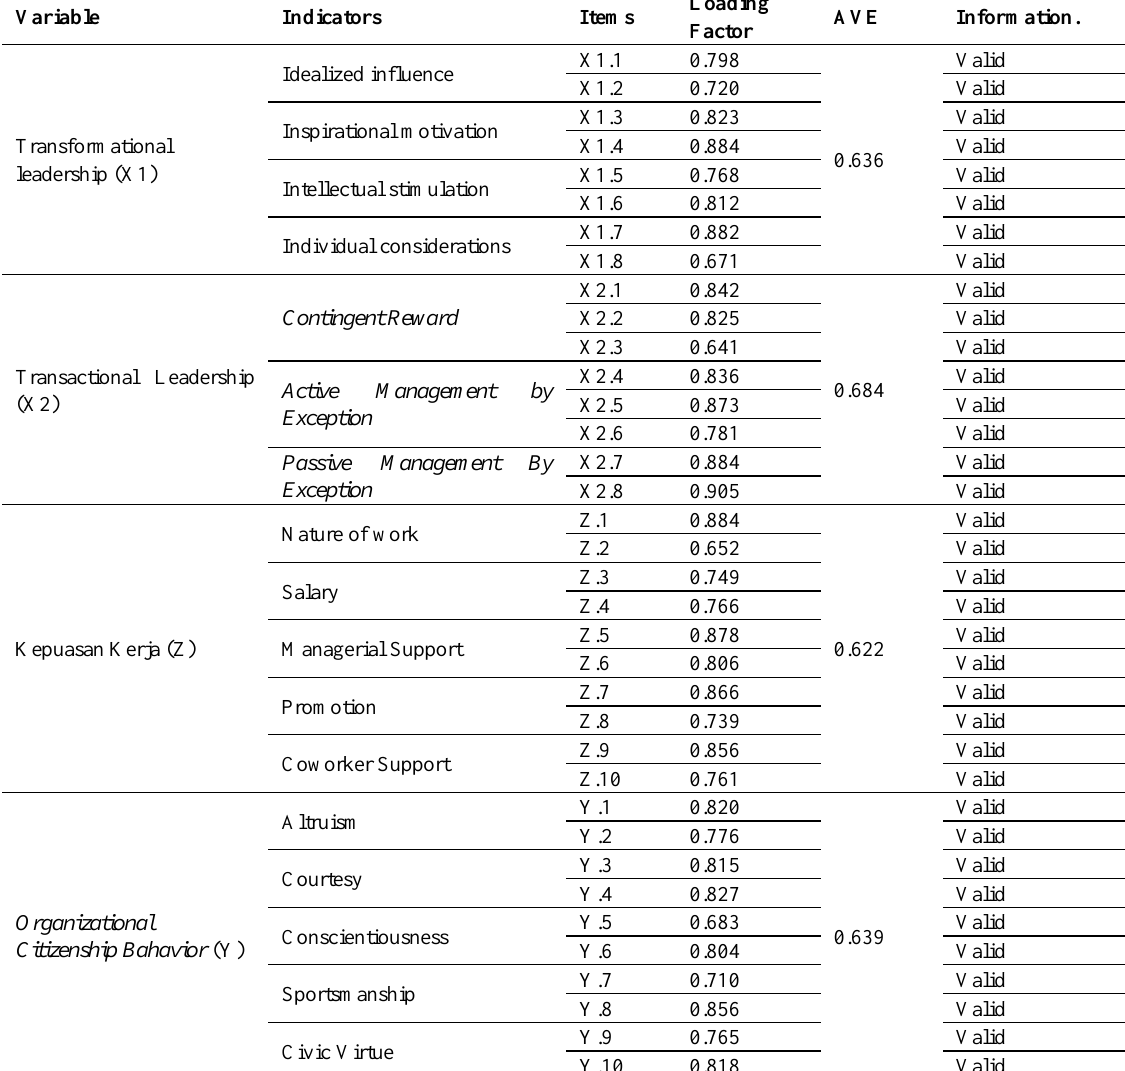
Table 2: Results of Instrument